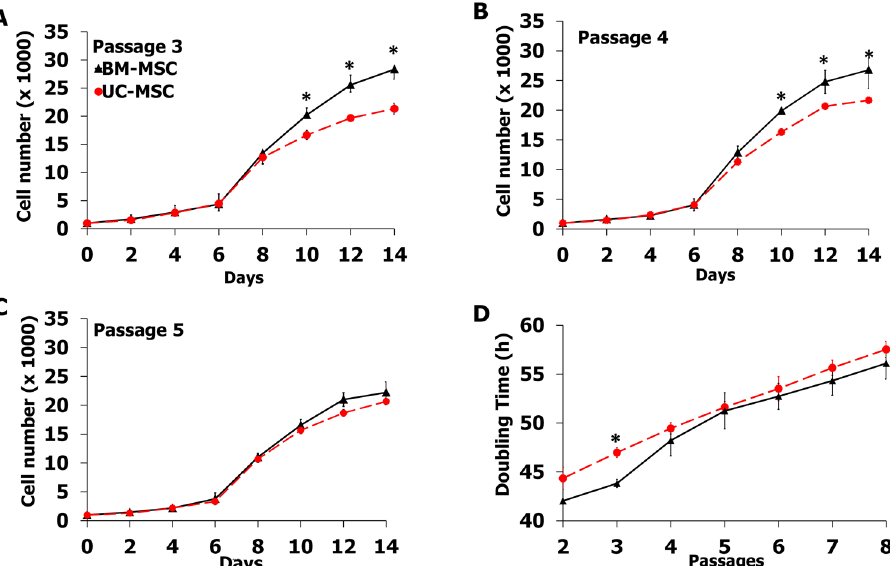
Figure 3. Growth characteristics of UC-MSCs compared to BM-MSCs. Triplicate cultures were harvested every 2 days for 14 days, and adherent cells were counted. ( A ) Growth curve of MSCs at passage 3, ( B ) Growth curve of MSCs at passage 4, ( C ) Growth curve of MSCs at passage 5. ( D ) Population doubling time of UC-MSCs compare to BM-MSCs. Results (N = 3) are expressed as mean ± SD. * P < 0.05: significant difference compared to